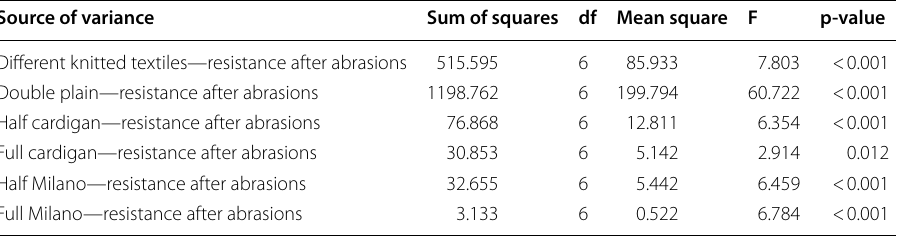
Table 6 One-way ANOVA carried out between different knitted textiles and abrasion Source of variance Sum of squares df Mean square F p‑value Different knitted textiles—resistance after